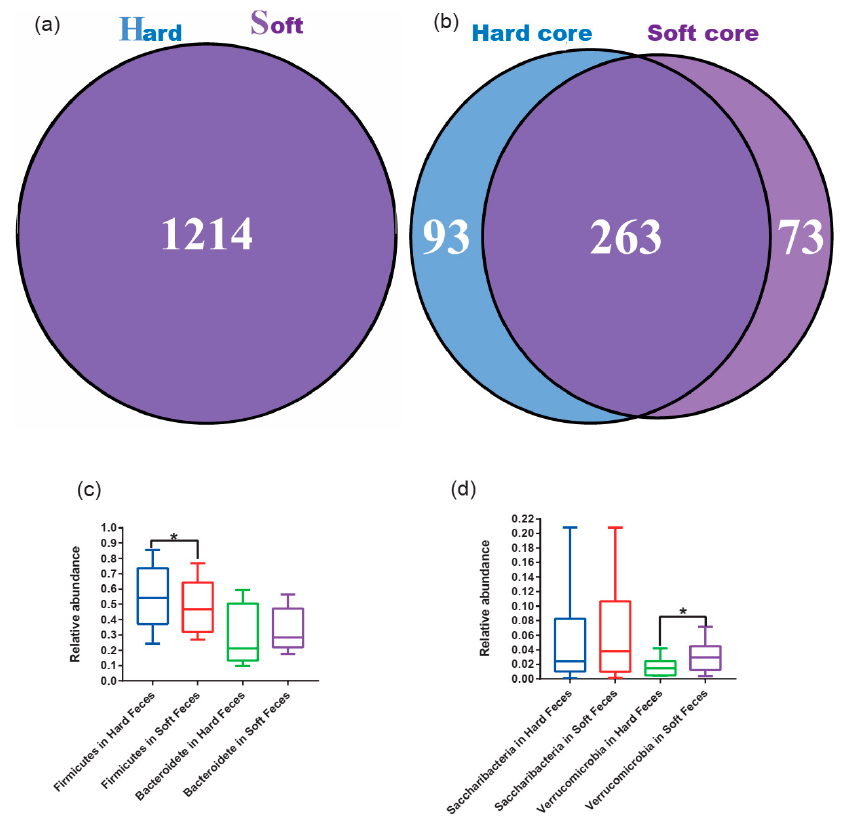
Figure 4. Core operational taxonomy units (OTUs) in hard (H) and soft feces (S); the “Hard core” and “Soft core” represent the core OTUs in hard and soft feces, respectively. ( a ) The shared OTUs between hard and soft feces based on the total OTUs. ( b ) The shared OTUs between hard and soft feces based on the core OTUs. ( c , d ) The dominant phyla (Wilcoxon rank-sum test: * p < 0.05).